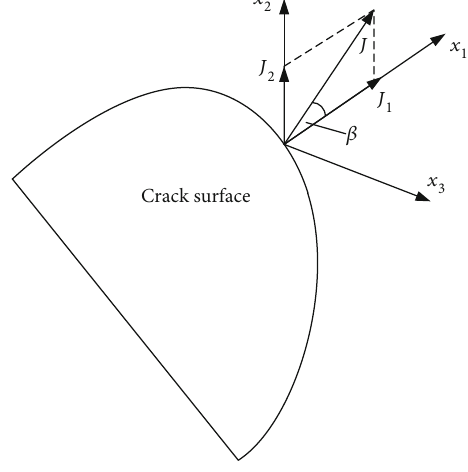
Figure 5: Eshelby-force vector J to describe fatigue-crack